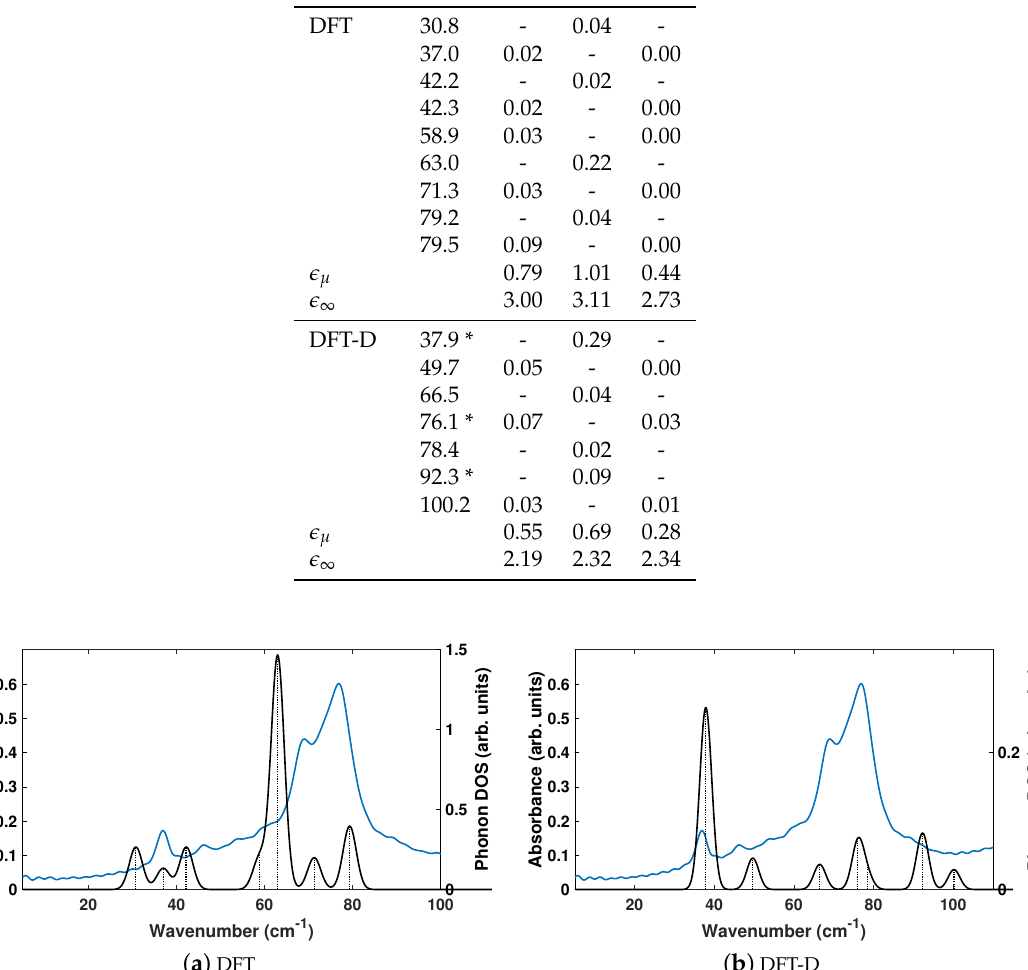
Table 5. Same description as Table 3, but for SA. Asterisks (*) denote the modes depicted in Figure 7. Method